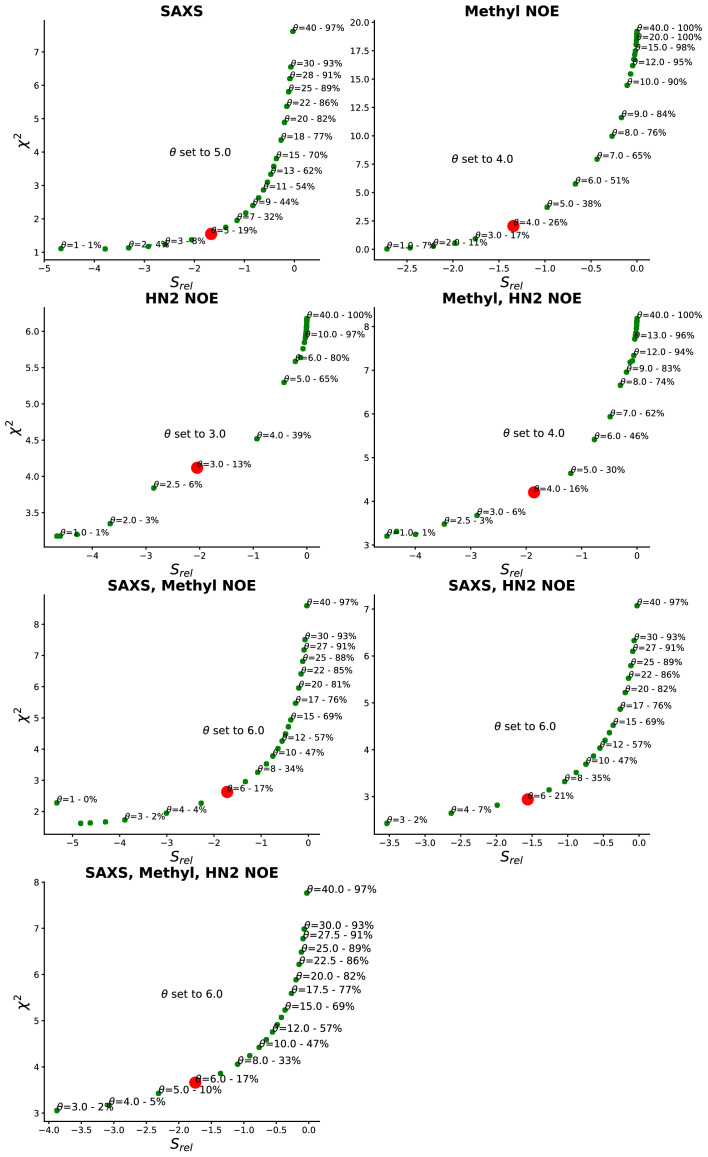
Determination of θ.θ is a hyperparameter that tunes the balance between fitting the data accurately (low χr2) and not deviating too much from the prior (low Srel) thereby avoiding overfitting. It is here determined by plotting Srel vs χr2 and selecting a value of θ near the natural kink and at a step where a similar decrease in χr2 gives rise to a much lower Srel, indicating that we cannot fit the to the experiments further without a risk of overfitting. The value of θ that produce the given (Srel,χr2) is annotated above the given point together with a measure of the effective number of frames used from the original simulation this gives rise to. Red dot marks the chosen θ.